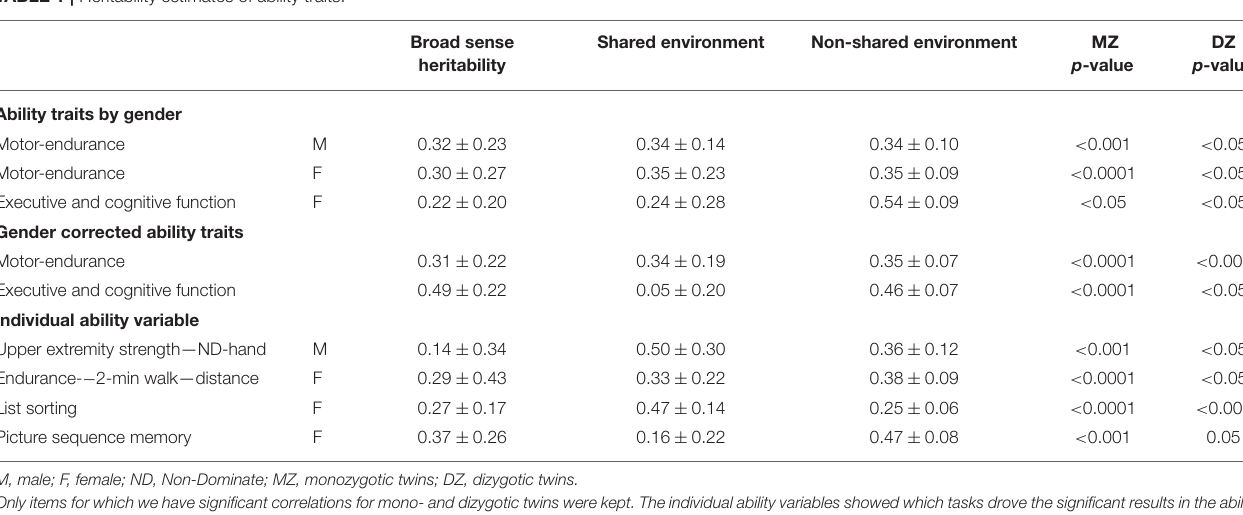
TABLE 1 | Heritability estimates of ability traits.